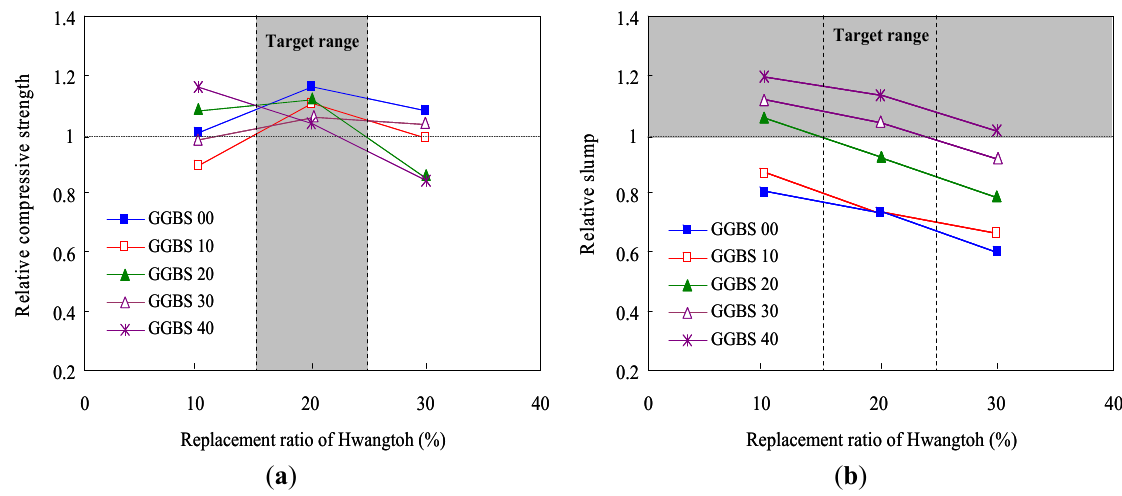
Figure 1. Relative compressive strength and slump test results on concrete samples. ( a )